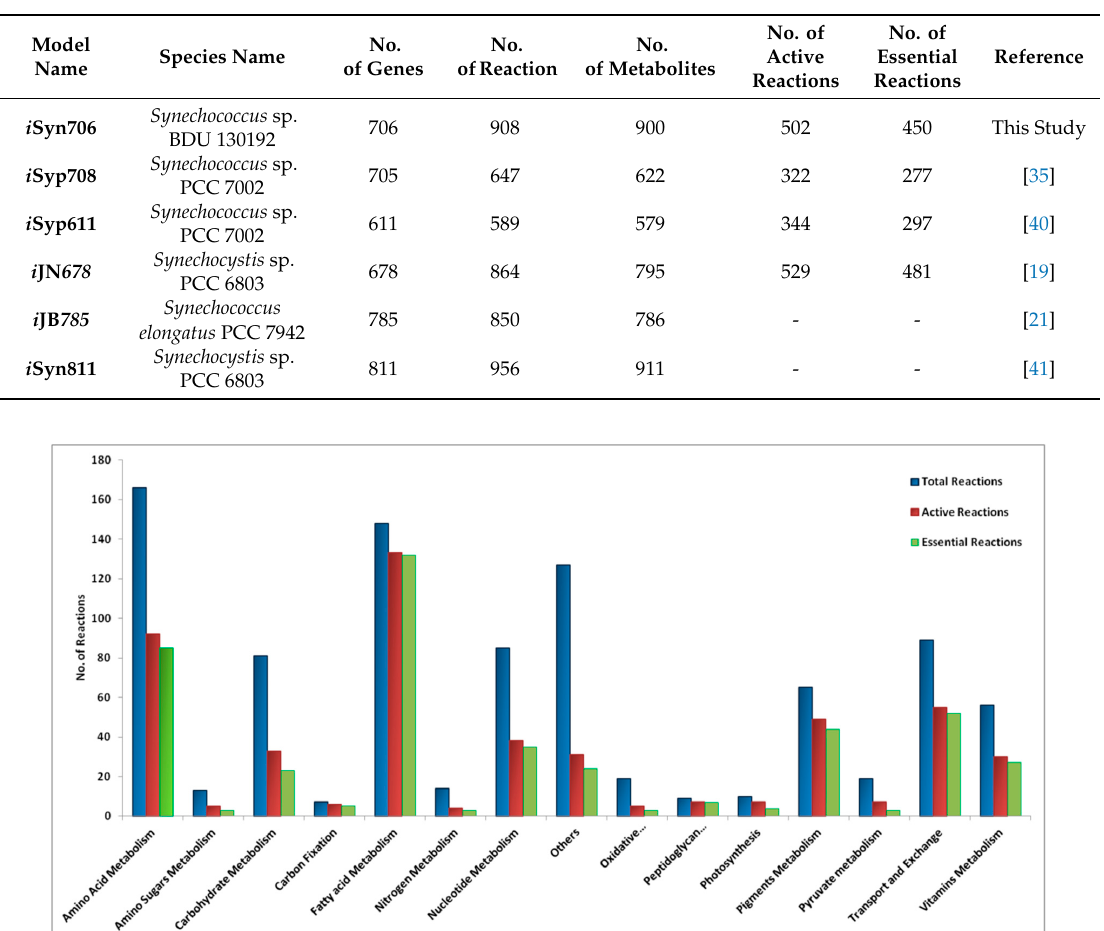
Figure 5. Distribution of total, active and essential reactions across various subsystems in i